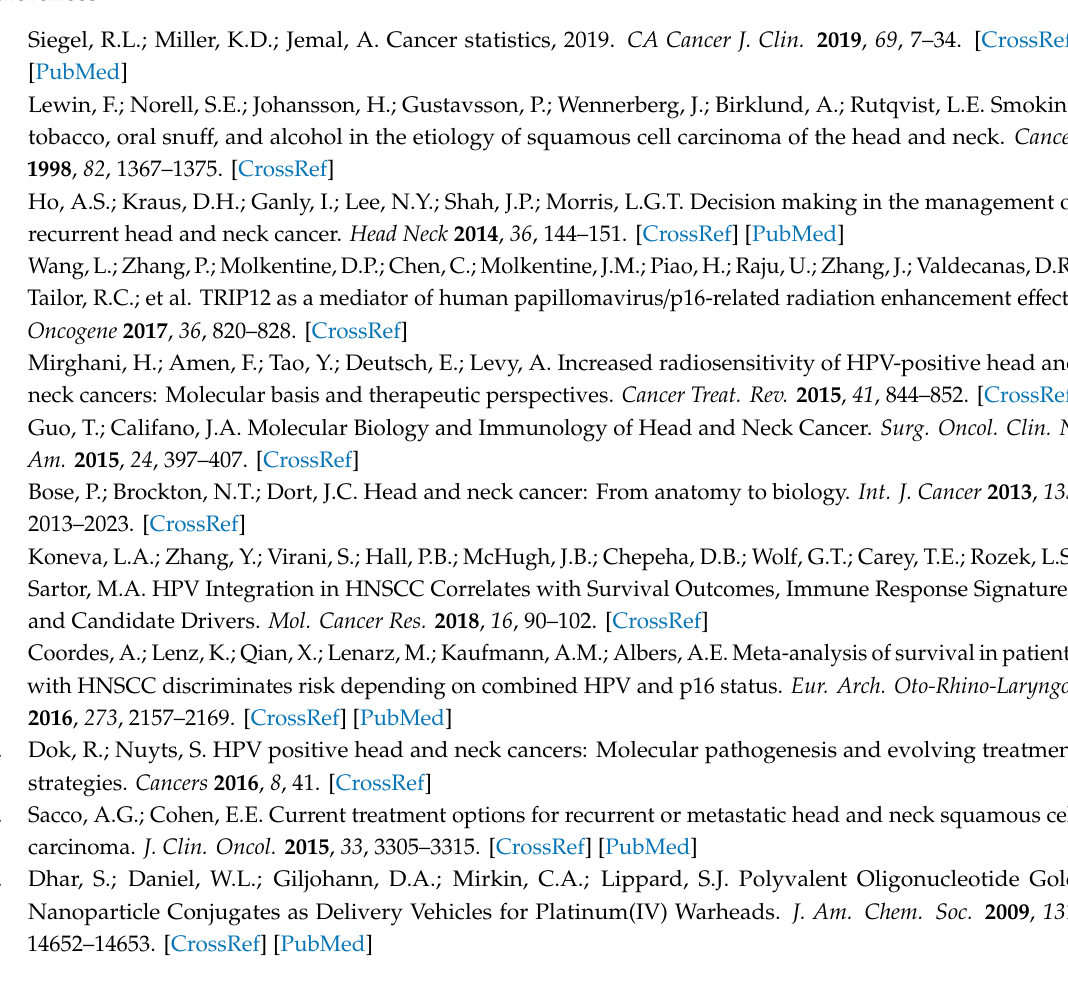
Figure S1: Physical-chemical characterization of NAs-CisPt, Figure S2: General structure of nano-architectures, Figure S3: Internalization of NAs-647 in HNSCC-25 and UPCI-SCC-154 cell lines, Figure S4: Cytotoxic e ff ect of Cisplatin against HNSCC-25 and UPCI-SCC-154, Figure S5: Cytotoxic e ff ect of standard gold nanoparticles against SCC-25 and UPCI-SCC-154, Figure S6: Bright field images of SCC-25 and UPCI-SCC-154 spheroids, Figure S7: Ultrastructural characterization of di ff erent layers of 3D UPCI-SCC-154, Table S1: Size and zeta potential of NAs, NAs-647 and NAs-cisPt, Table S2: IC50 measurements for SCC-25 and UPCI-SCC-154 measured 24 h after treatment with free or nanoparticles-loaded cisplatin, Table S3: Viability of SCC-25 spheroids after treatment with NAs-cisPt, Table S4: Viability of UPCI-SCC-154 spheroids after treatment with